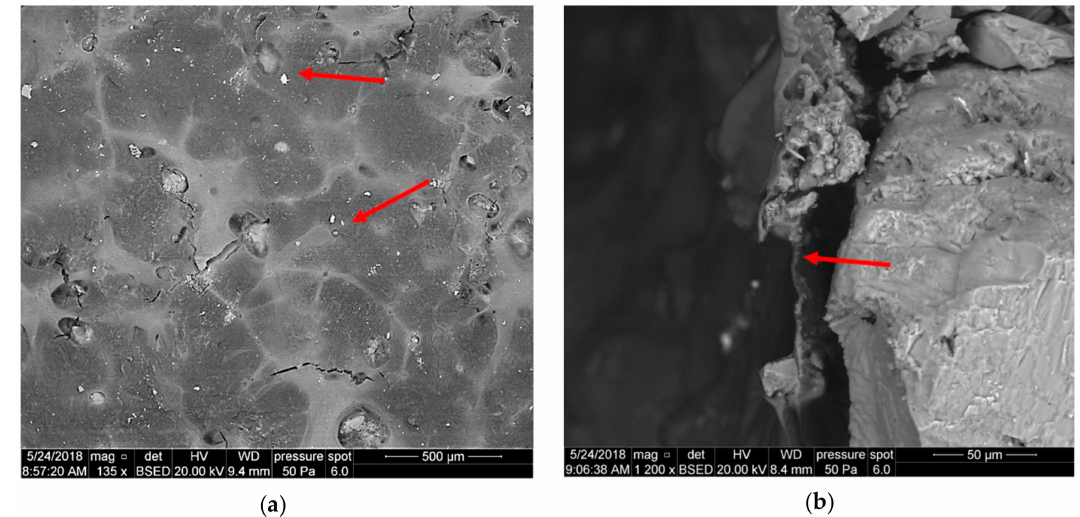
Figure 14. SEM image of the 3229 core face after contact with foamed U-2 and polimer S.F. 3b, ( a ) top view of the core face, ( b ) side view of the core